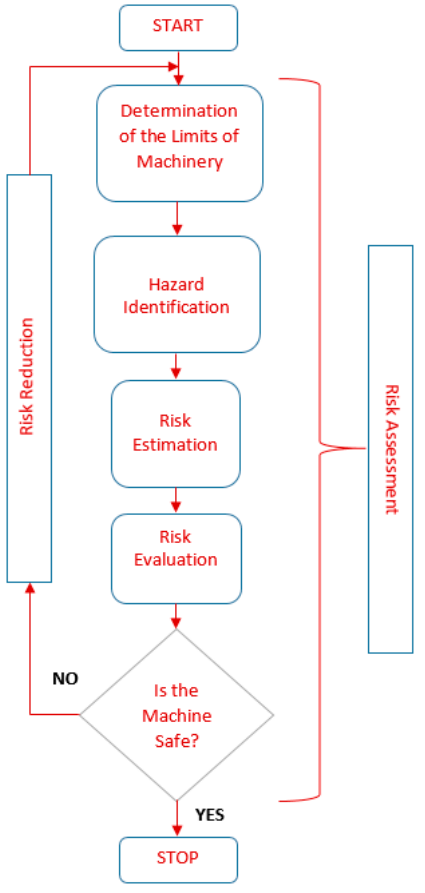
Figure2. RiskmanagementflowchartregardingtheriskassessmentprocessaccordingtoISO12100:2010. Figure 2. Risk management flow chart regarding the risk assessment process according to ISO12100:2010.